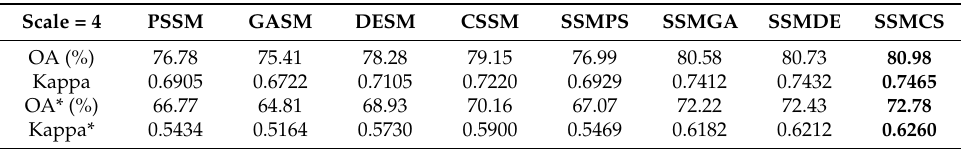
Table 3. Comparison of the sub-pixel mapping algorithm performances for the Landsat TM image in Experiment